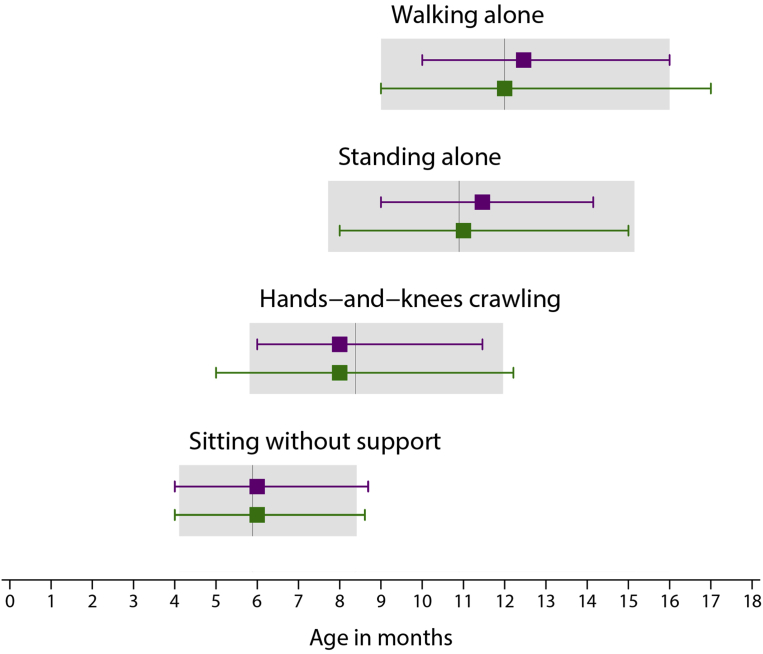
Gross motor development milestones for included infantsMedian age of achievement (3rd and 97th centiles) of 4 gross motor development milestones for infants that were included in the INTERGROWTH-21st Fetal Growth Standards (purple) and those included in the present analysis (green). For comparison, the median, 3rd and 97th centiles of the WHO windows of achievement for the same milestones are presented as gray bars.Drukker et al. International gestational age-specific centiles for umbilical artery Doppler indices: a longitudinal prospective cohort study of the INTERGROWTH-21st Project. Am J Obstet Gynecol 2020.